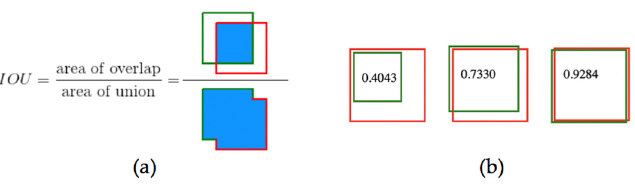
Figure 6. Visualizations of IoU (Intersection over Union): ( a ) The visualization of IoU calculation formula, it is the fraction of the overlapping area and the union area of two bounding boxes, ( b ) the ground truth bounding boxes are shown in red, predicted bounding boxes are shown in green, and their IoUs are shown in the